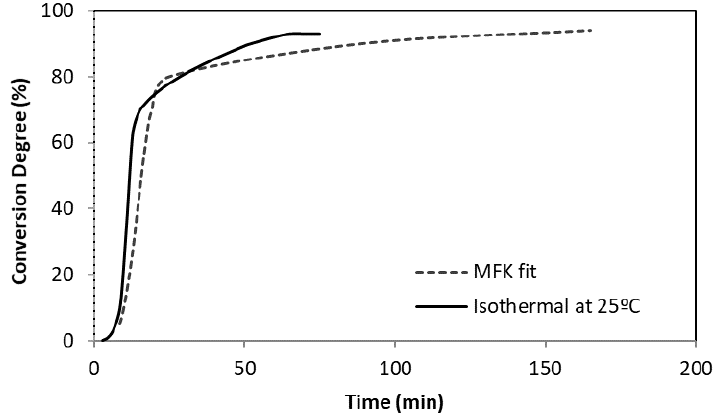
Figure 4. Comparison of the conversion degree between the curing isothermal model and real isothermal process (0.1 wt.% G-PMMA bone